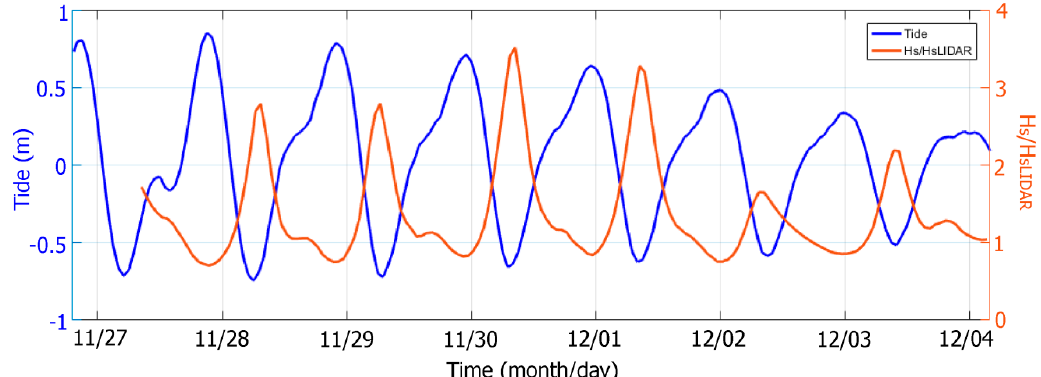
Figure 6. Timeseries of the ratio between offshore significant wave height (H s ) and significant wave height measured on the lower foreshore by the Lidar (H sLIDAR ) is shown in orange and the tidal elevation is in blue.